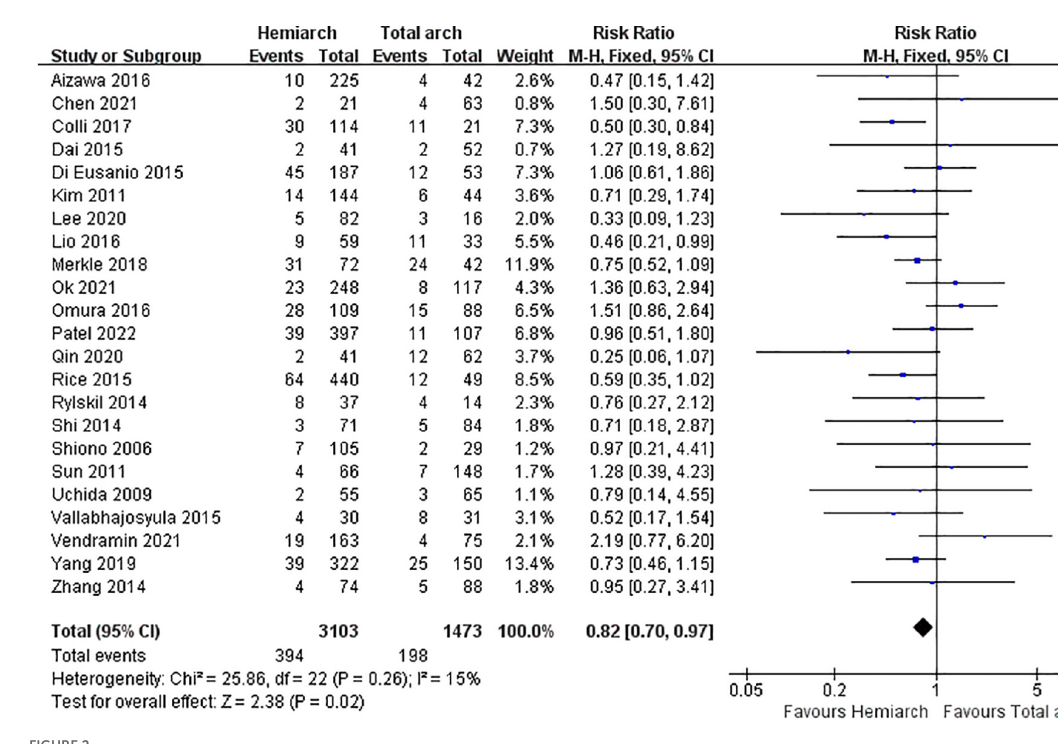
FIGURE2 Forest plot of early mortality.